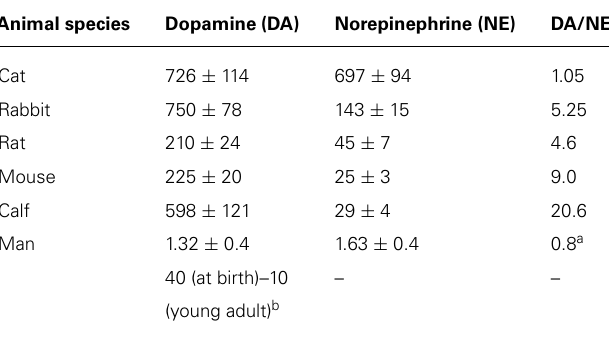
Table 1 | Catecholamine content in the CB of several mammalian species. Animal species